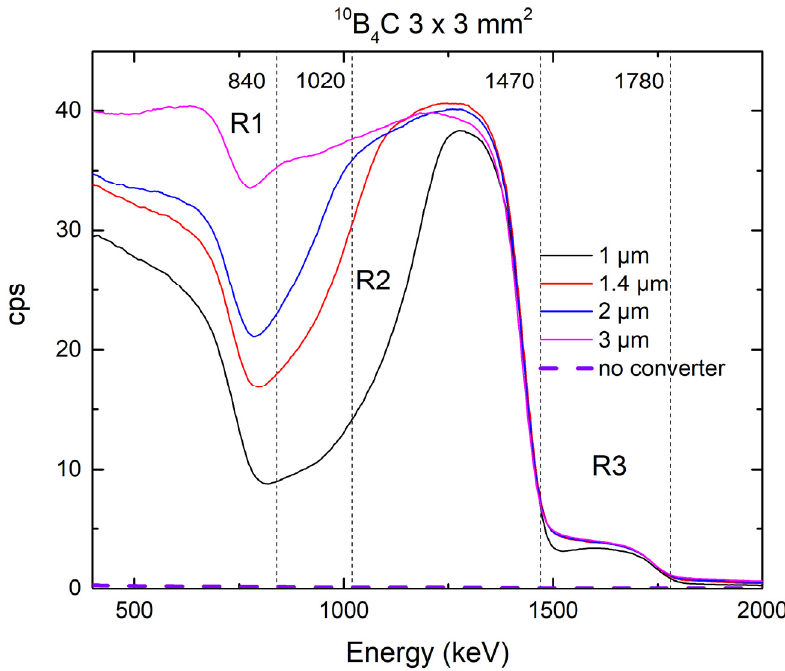
Figure 3. Response of the 4H-SiC SBD detector (3 mm × 3 mm) equipped with 10 B 4 C thermal neutron converter layers with thicknesses of 1.0, 1.4, 2.0, and 3.0 µm to the neutron field of the JSI TRIGA reactor at 250 kW.